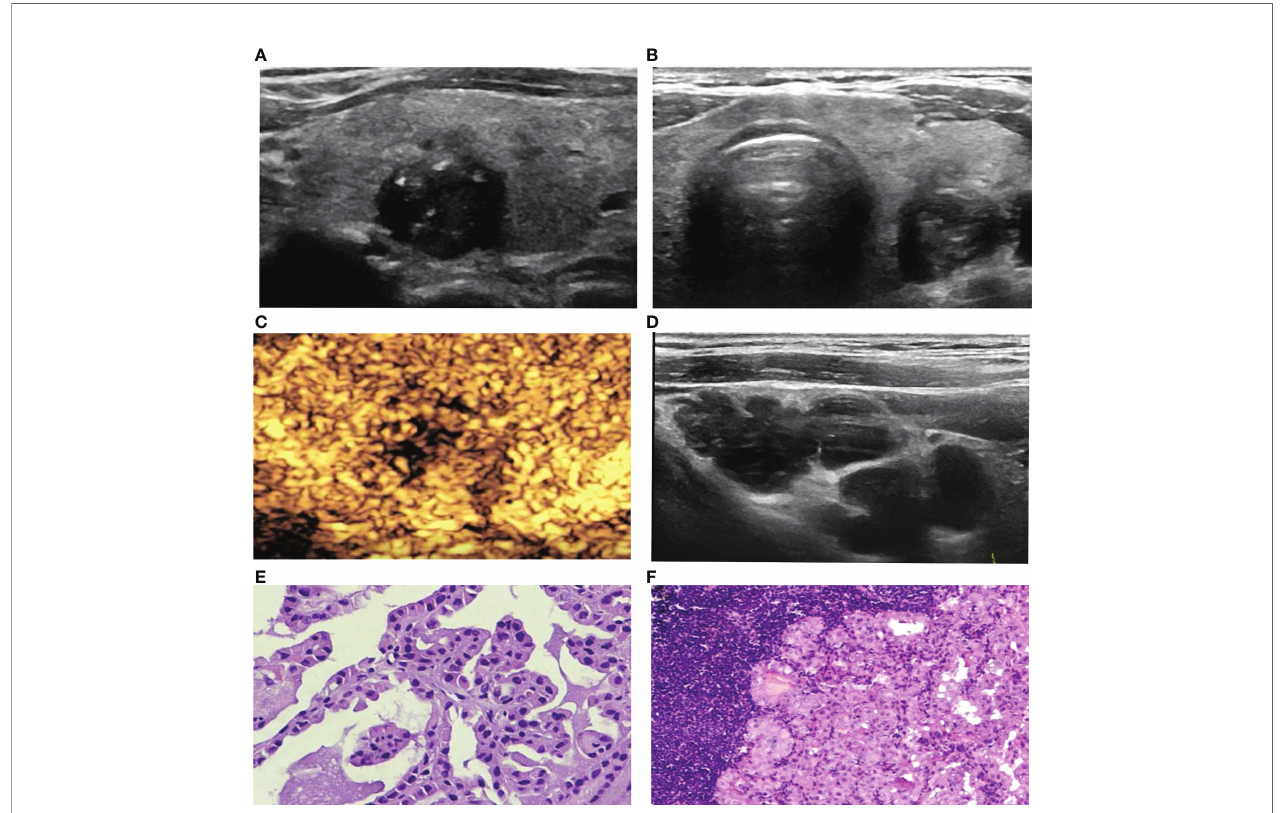
FIGURE 3 | A 67-year-old woman with PTC. (A) Preoperative ultrasound images showing that the size of the tumor was approximately 1.2*1.0*1.3 cm in the left lobe, the margin was irregular, taller than wide, and calci fi cation was detected. (B) Transverse sonogram showing that the contact range with the capsule was approximately 25%-50%. (C) CEUS showing heterogeneous hypoenhancement in the nodule. (D) Metastatic lymph node showing that the normal structure disappeared, presenting cystic changes. (E) Surgical pathology con fi rming PTC (HE, original magni fi cation, ×100). (F) Surgical pathology con fi rming cervical lymph node metastasis from PTC, (HE, original magni fi cation,